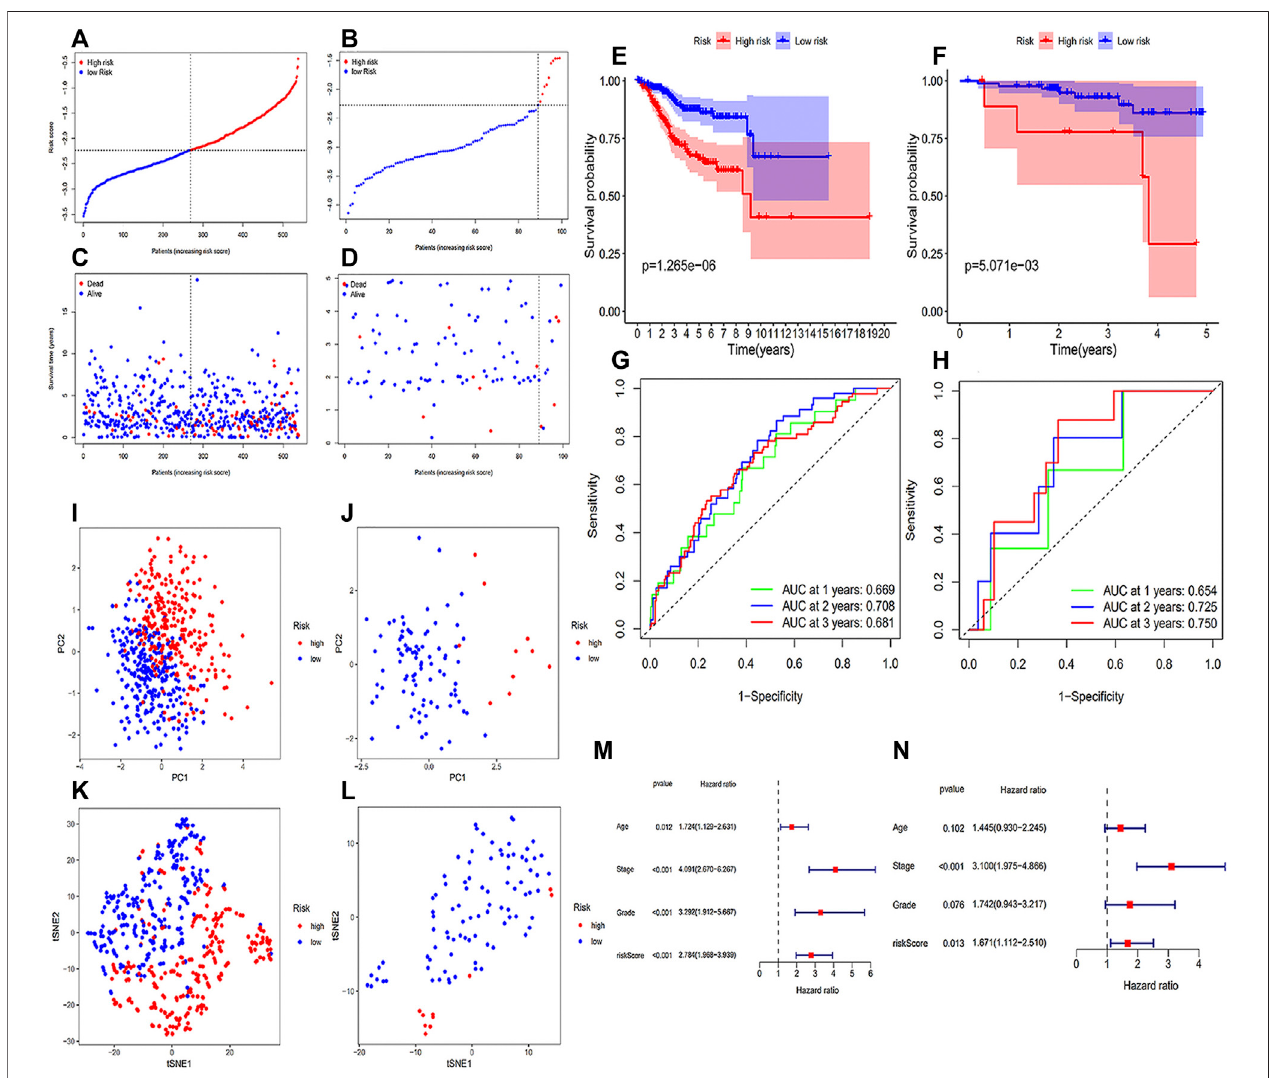
FIGURE2| Constructionandvalidationoftheprognosticsignature. (A) Thedistribution andmedianvalueoftheriskscoresofpatients fromthetrainingcohort; (B) Thedistributionandmedianvalueoftheriskscoresofpatientsfromthetestingcohort; (C) Survivalstatusdistributioninthetrainingcohort; (D) Survivalstatusdistribution in the testing cohort. (E) The Kaplan-Meier curves for the OS of patients in the training group; (F) the Kaplan-Meier curves for the OS of patients in the testing group; (G) the ROC curves in the training group; (H) the ROC curves in the testing group. (I) PCA plot of the training cohort; (J) PCA plot of the testing cohort; (K) t-SNE analysis result of the training cohort; (L) t-SNE analysis result of the testing cohort. (M , N) Independent prognostic factors in the univariate (M) and multivariate Cox regression (N) .